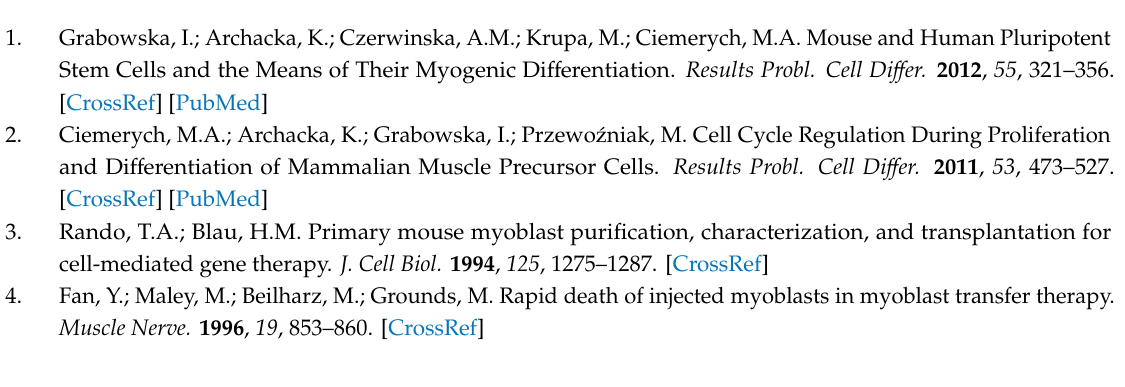
Table S1: Taqman assays used in qPCR analyses. Table S2: List of genes whose expression was changed as a result of IL-4, SDF-1, or IL-4 and SDF-1 treatment and which were visualized in Venn graphs (Figure 8B). Table S3: Selected molecular and cellular functions predicted to di ff er between IL-4 and SDF-1 and control, i.e., non-treated hADSCs (according to Gene Ontology and GO